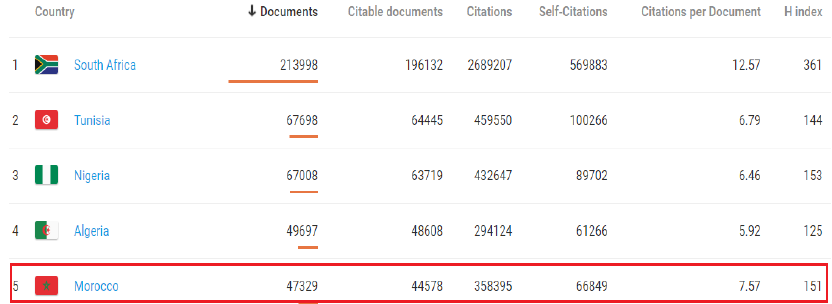
Table 2. Ranking of African Countries by Number of Scientific Publications from 1996